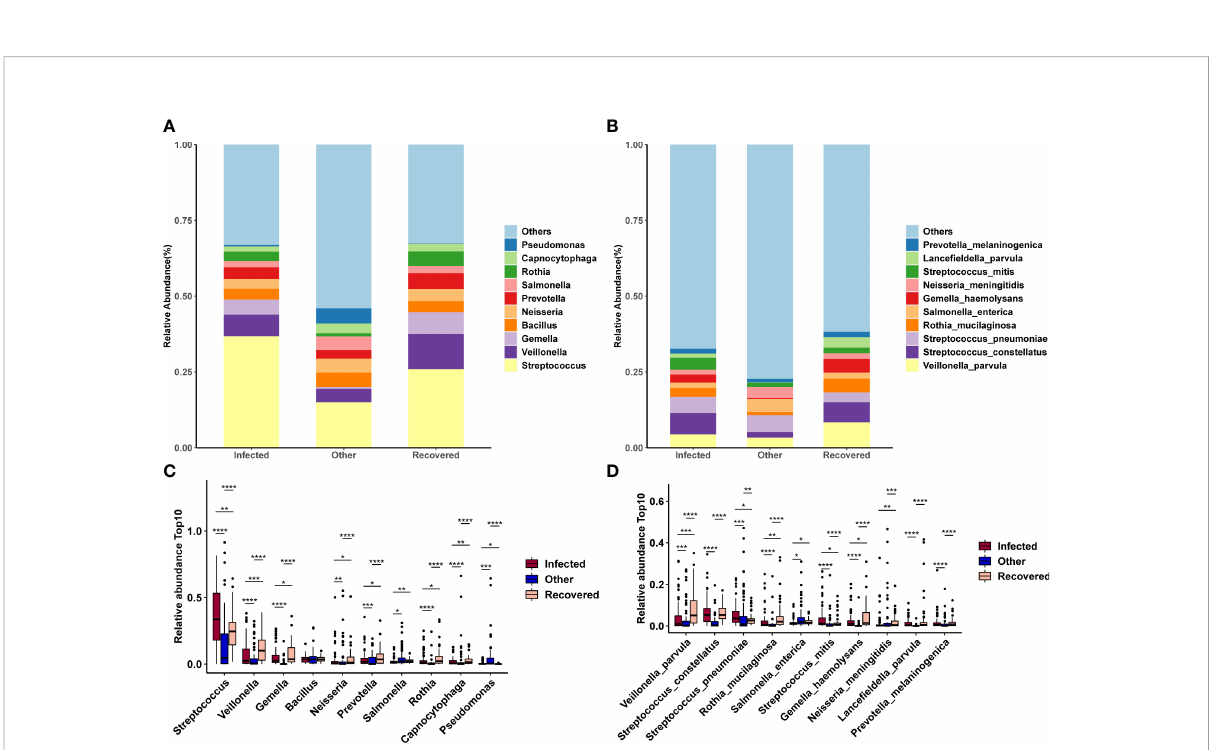
FIGURE 4 Changes in microbial composition across groups. (A, B) Microbial composition of the top 10 taxa at the genus (A) and species (B) levels. (C, D) Differences in the microbial composition of the top 10 taxa between groups at the genus (C) and species (D) levels. *, **, ***, and **** indicates a p-value < 0.05, 0.01, 0.001, and 0.0001 (Wilcoxon test),